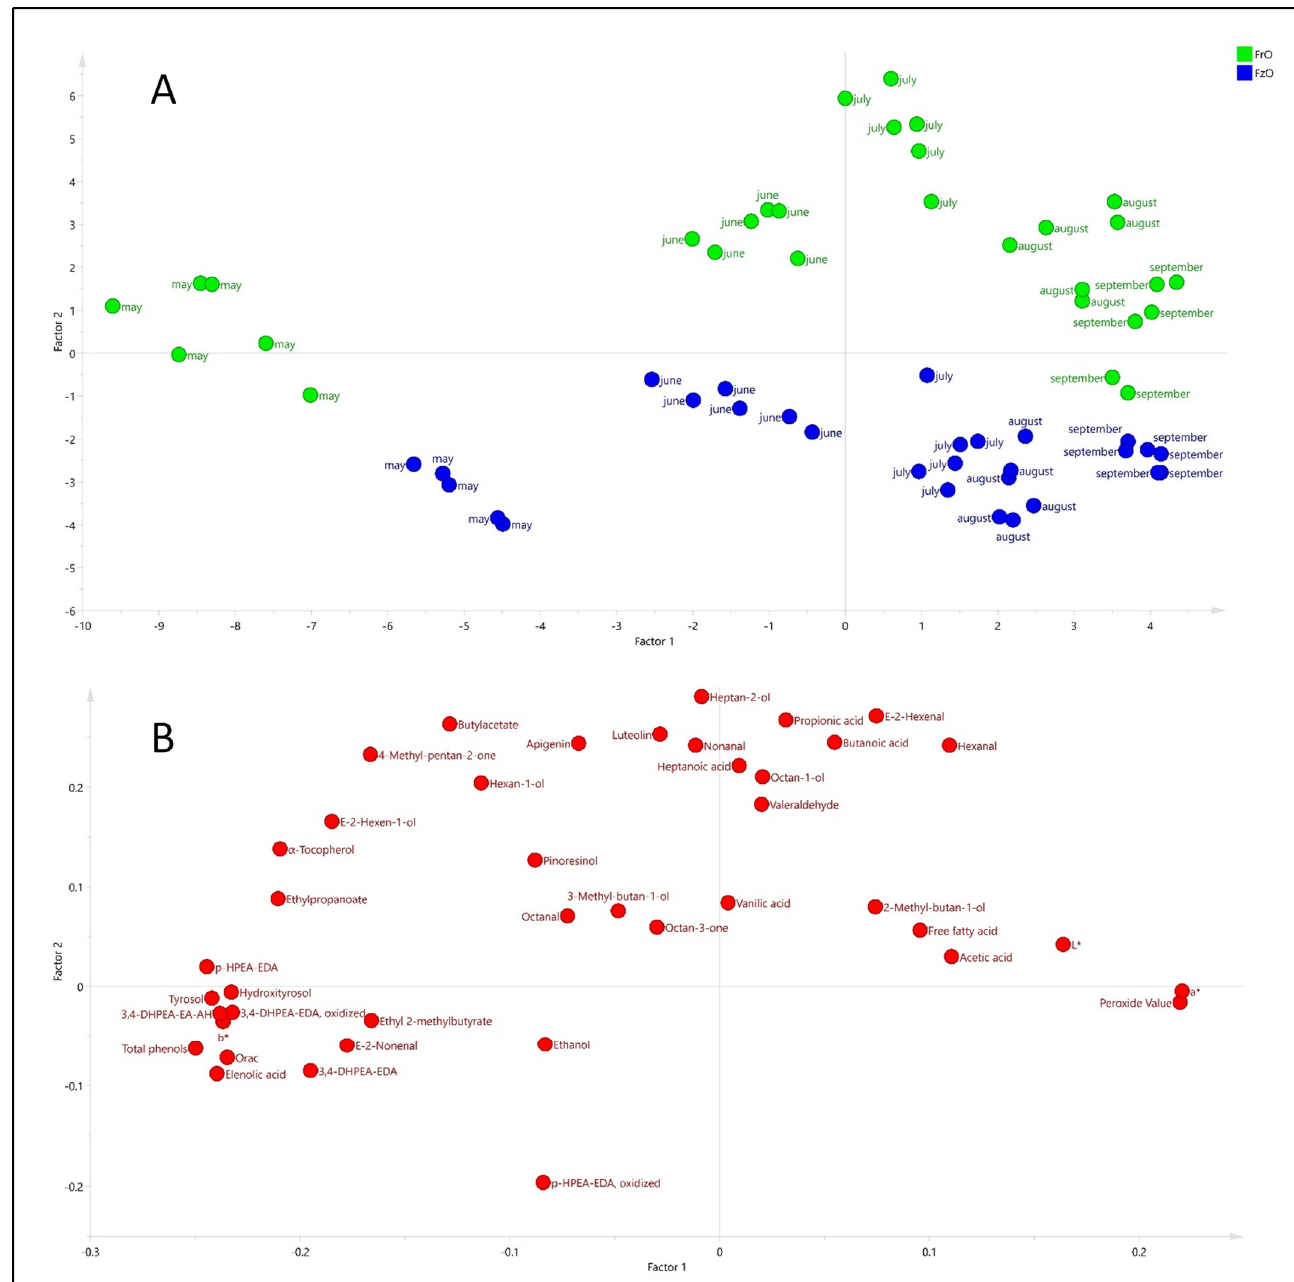
Figure 4. Results of principal component analysis (PCA) carried out with 42 variables. The scores ( A ) and loading ( B ) plots are shown, and virgin olive oils extracted from fresh (FrO) and frozen (FzO) olives are highlighted with different color.